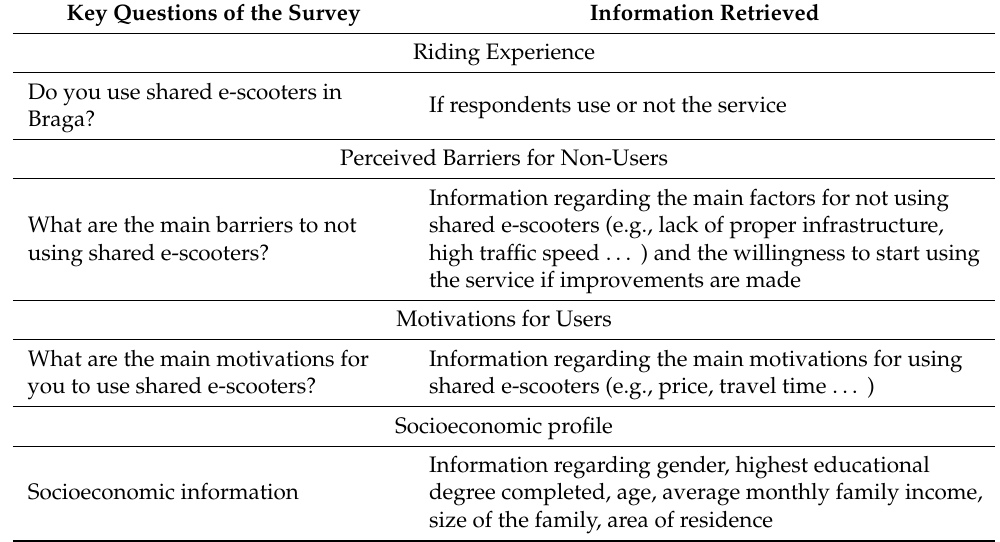
Table 2. Key aspects collected in the